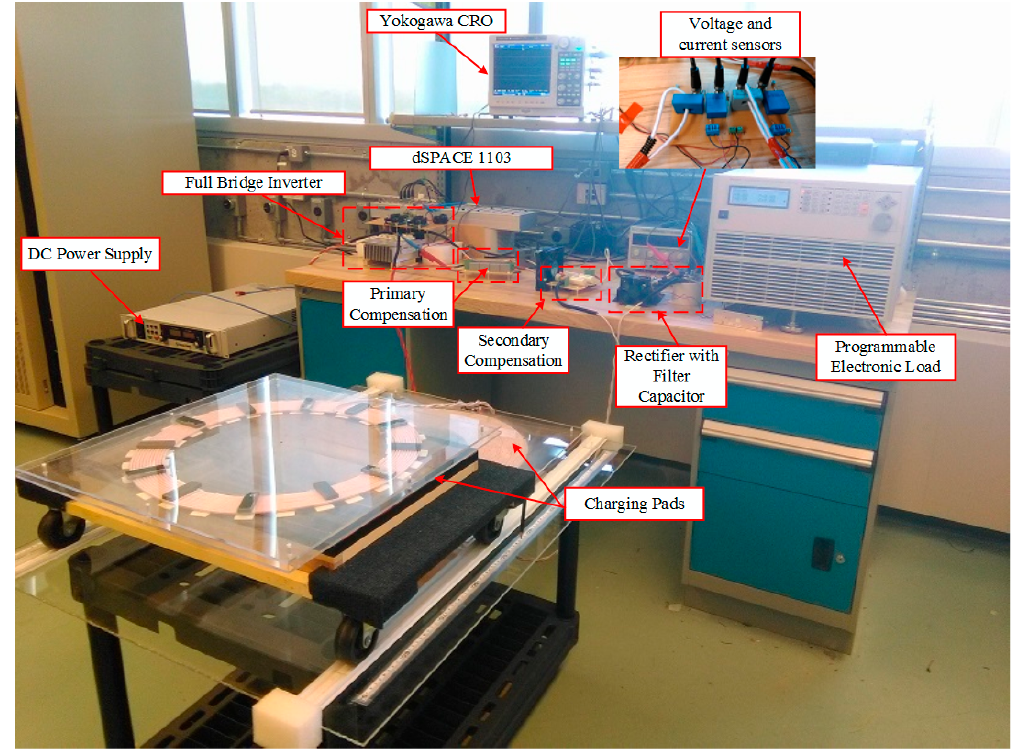
Figure 8. Experimental setup.